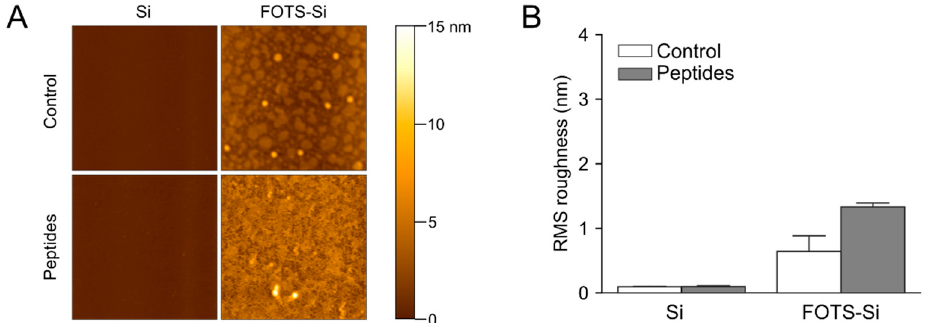
Figure 5. AFM of peptide adsorption by PDMS patterning. A vehicle control (acetic acid) or collagen peptide solution (250 µ g / mL of CRP, GFOGER, and VWF-III each) was incubated in a PDMS well on silicon (Si) or silicon functionalized with FOTS (FOTS-Si) ( A ) Representative images of each surface. Scale bar = 3 µ m. ( B ) Average RMS roughness for each surface for n = 3, error bars represent standard deviation.